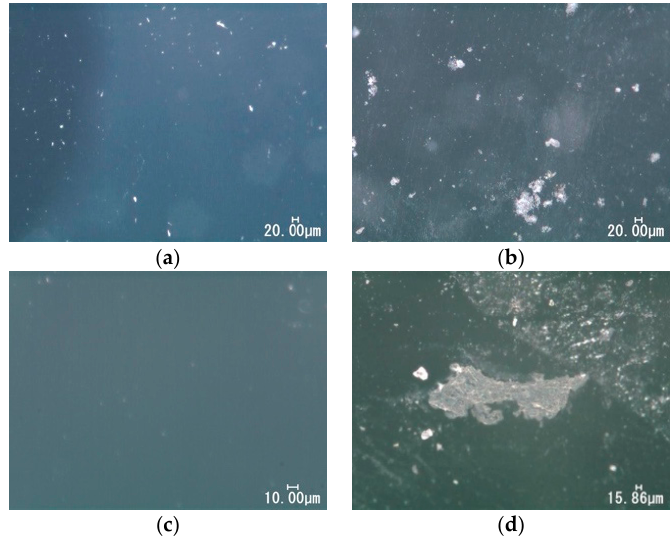
Figure 7. Optical microscopic images for polymeric specimens. ( a ) Silicon before immersion; ( b ) silicon after immersion; ( c ) polyurethane before immersion; ( d ) polyurethane after immersion.